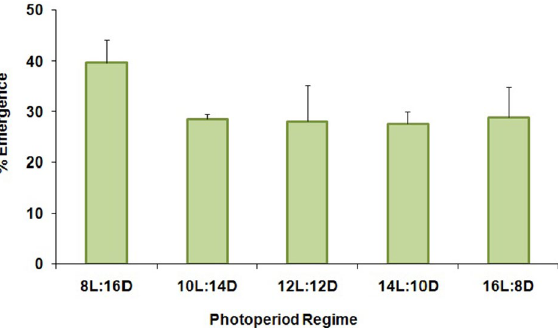
Figure 2. Percentage (% ± SE) of adult emergence in P. interpunctella larvae reared at 17 °C and different photoperiod